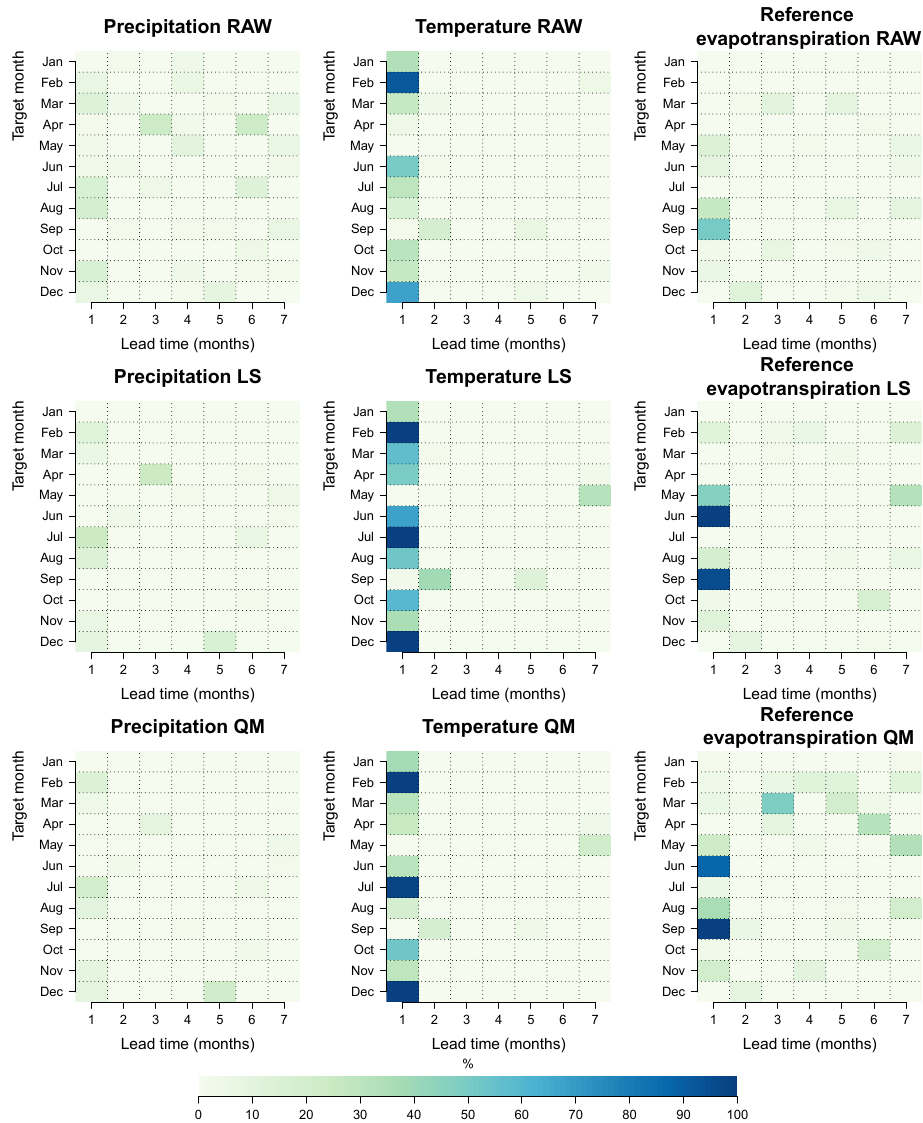
Figure 9. Percentage of grid points with statistically significant positive CRPSS (see Eq.